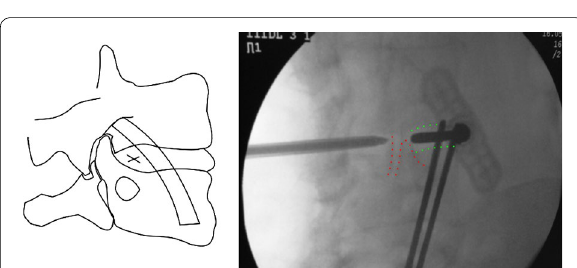
Fig. 2 Lordosis of the C‑arm is adjusted on the AP view to obtain a perfectly parallel view of the vertebral endplates of the target disc (green dotted lines). Following this, lateral tilt of the C‑arm is adjusted to obtain an oblique view of the target disc making sure that the articular facet is correctly visualised in the posterior third of the disc space (red dotted lines). The entry point into the disc is marked on the schematic drawing (left